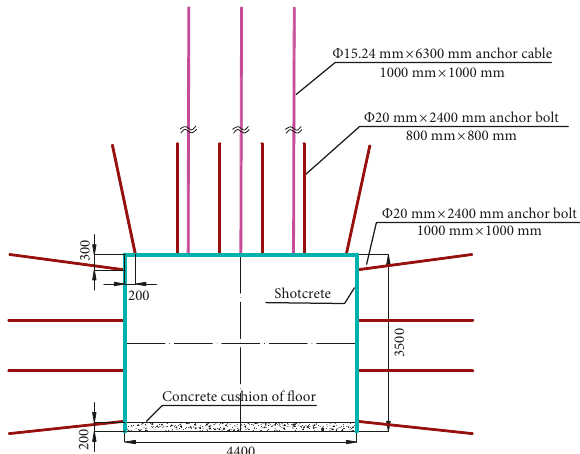
Figure 15: The combined support of the lower roadway “bolt+ cable+U-shaped steel support passive reinforcement + shotcrete”.